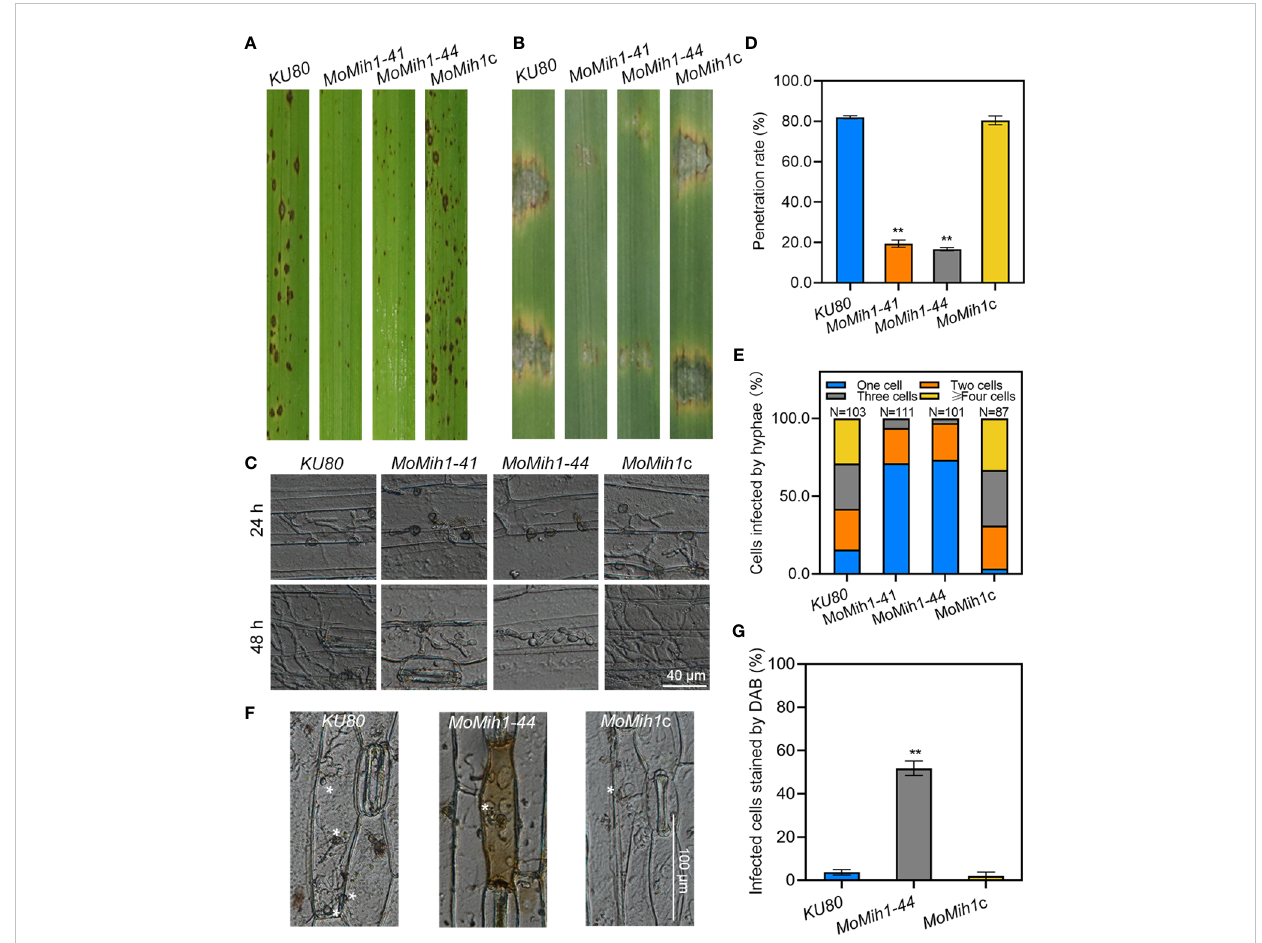
FIGURE 5 MoMih1 is essential for pathogenicity of M. oryzae . (A) Deletion of MoMih1 affects the virulence of M. oryzae on rice leaves. Conidia suspension of the MoMih1 mutants were sprayed on the rice seedlings, and the diseased leaves were collected at 5 dpi. (B) Pathogenic assays on barley leaves. Conidial suspension of KU80 , MoMih1 mutants and MoMih1 c was inoculated on barley leaves, and the diseased leaves were collected at 5 dpi. (C) Penetration assay. Conidial suspension of KU80 , MoMih1 mutants and MoMih1 c was inoculated on the barley leaves, cultured under the condition of 28°C for 24 h or 48 h, and then examined under light microscopy. (D) Statistical analysis of penetration rate. The appressoria mediated penetration of barley epidermal cells were examined, measured at 24 hpi, and then statistically analyzed. “ ** ” represents signi fi cant difference between KU80 and MoMih1 mutants ( p < 0.01), and error bars represent SD. (E) The MoMih1 deletion affects the invasive hyphae expansion. The percentage of plant cells occupied by the invasive hyphae of each strain was measured and analyzed at 48 hpi. (F) The MoMih1 deletion resulted in the accumulation of ROS at infection sites. Conidial suspensions (1 × 10 4 spores mL -1 ) of KU80 , MoMih1-44 mutant and MoMih1 c were inoculated on barley leaves for 24 h, and then stained with DAB solution. Plant cells infected by the MoMih1 mutant was mostly stained with DAB. Bar = 100 m m. (G) Statistical analysis of the proportion of plant cells stained by DAB. “ ** ” means signi fi cant difference between KU80 and MoMih1 mutants ( p < 0.01), and error bars represent